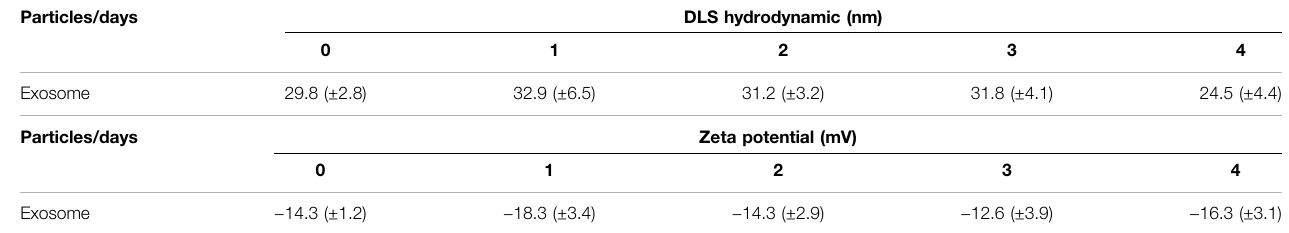
TABLE 1 | Identi fi cation of exosomes derived from MSCs.